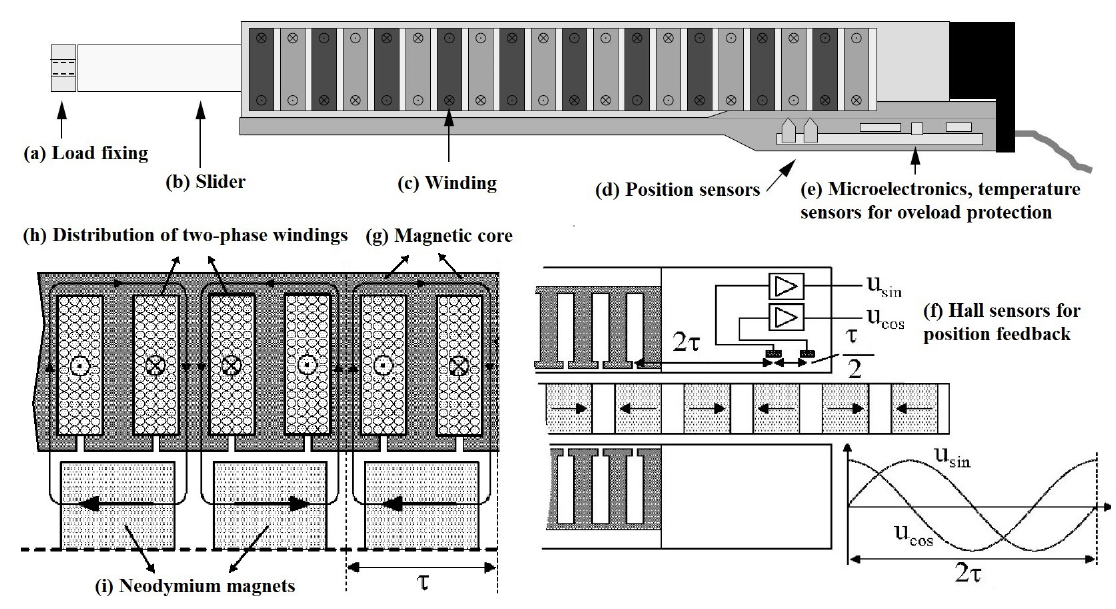
Figure 1. Structure of polysolenoid linear motor provided by